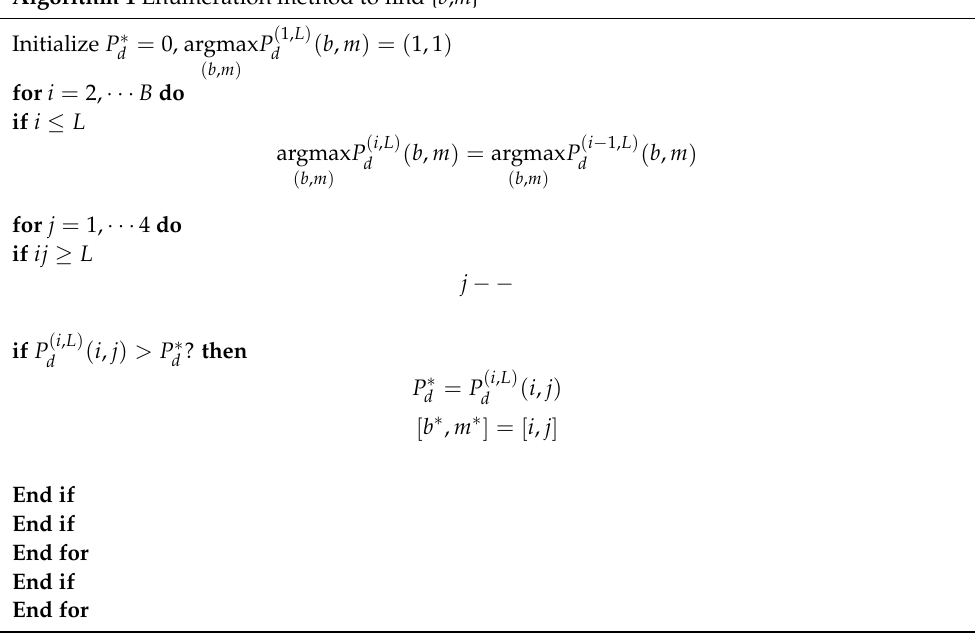
Algorithm 1 Enumeration method to find { b , m }